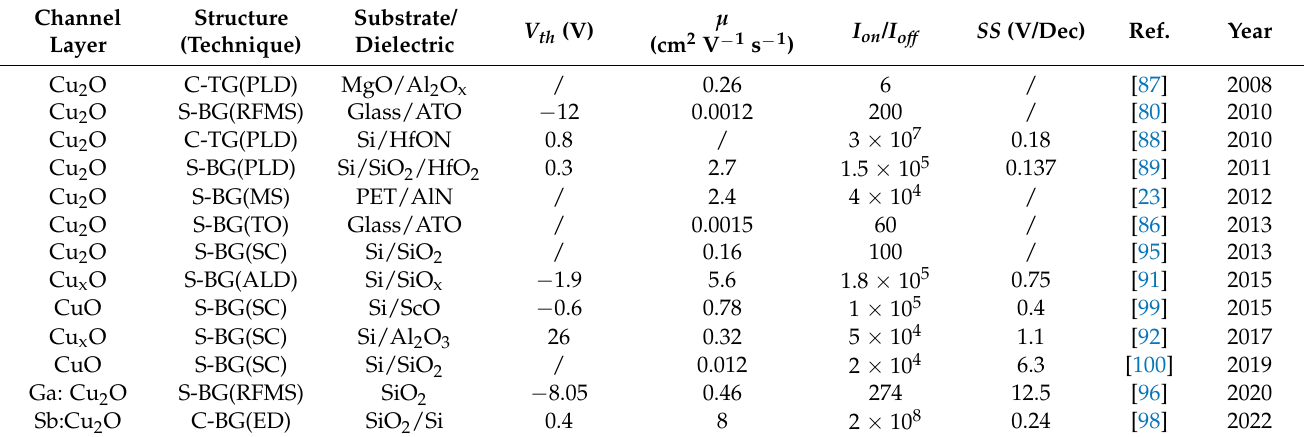
Table 3. Performance analysis of Cu 2 O p-Type thin film